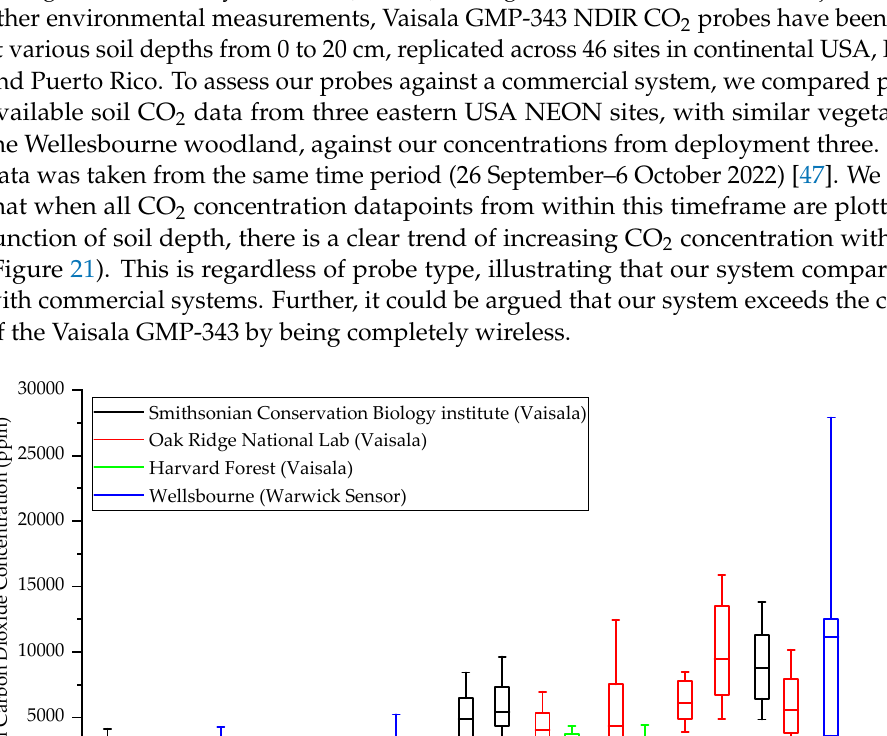
Figure 20. VOC measurements for the third deployment in Wellesbourne campus woodland. Data collection commenced on 26 August 2022 at 16:00 (24 h time).